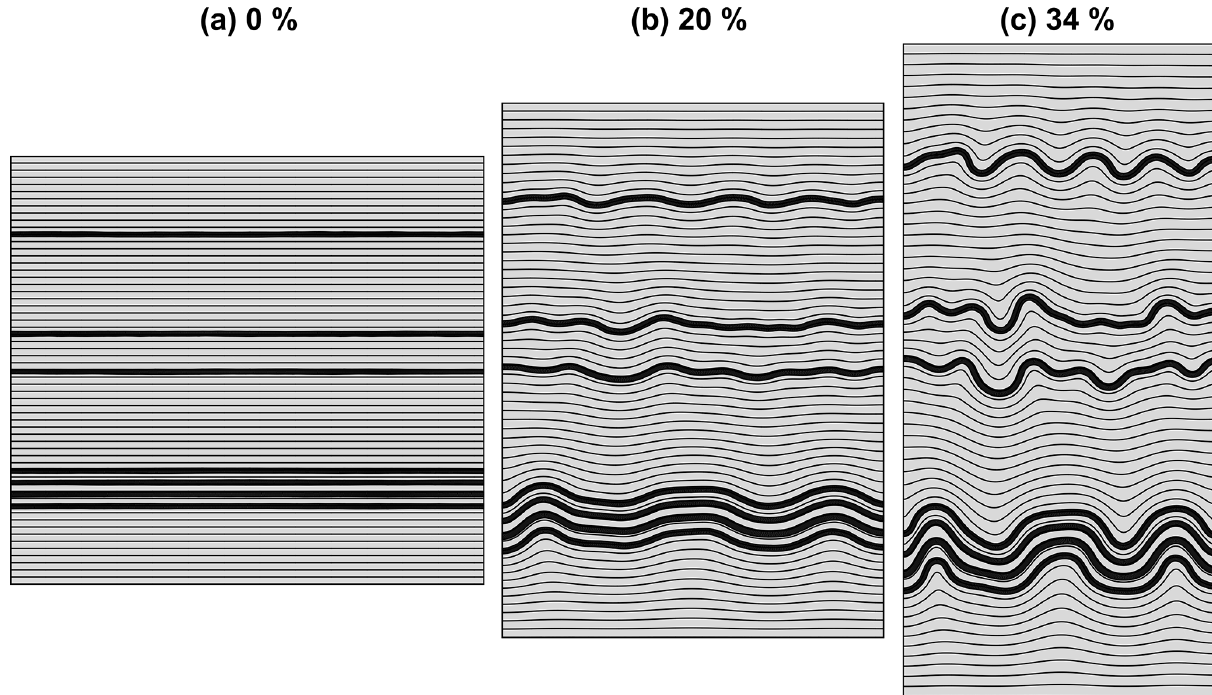
Figure 19. Result of a numerical simulation (performed for this study) of linear viscous multilayer folding for a viscosity ratio of R = 75 between competent layers (black) and weak embedding medium (grey). The initial model width is 100 times the identical initial thickness of all the competent layers. All layer interfaces have a small initial random geometrical perturbation with amplitudes ∼ 1 / 20th of the layer thickness. Thin dark-grey lines are passive lines indicating the finite deformation. The lowest four layers are closely spaced (spacing 1.5 times the layer thickness) and form harmonic folds because the four layers cannot fold independently ( b , c ; numbers in % indicate bulk shortening). The two layers in the middle of the model have a spacing 7 times the layer thickness. These two layers do not form harmonic folds but they do influence each other, as can be seen from the passively folded marker lines between the two layers (b, c) . The top layer develops single-layer folds that are effectively independent of the layer below, as shown by the fact that the thin passive lines between the top and second to the top layer remain almost straight. The results also show that amplification rates for multilayers are greater than for single layers, because fold amplitudes in the lowest four-layer stack are larger than amplitudes in the top single layer for the same bulk shortening (b, c) . Fold wavelengths in the bottom four-layer stack are also larger than the ones in the top single layer. Spacing between the bottom layer and the model bottom and between the top layer and the model top is 16 times the layer thickness. Spacing between the fourth and fifth layer from the bottom and the top and second to the top layer is 20 times the layer thickness. The dominant wavelength to thickness ratio for single layers is ∼ 15 for R = 75. The spacing between the top two layers (i.e. 20) is thus slightly larger than the dominant wavelength (i.e. 15), so that the observed independent or “disharmonic” folding of these two layers agrees with the concept of contact strain (see